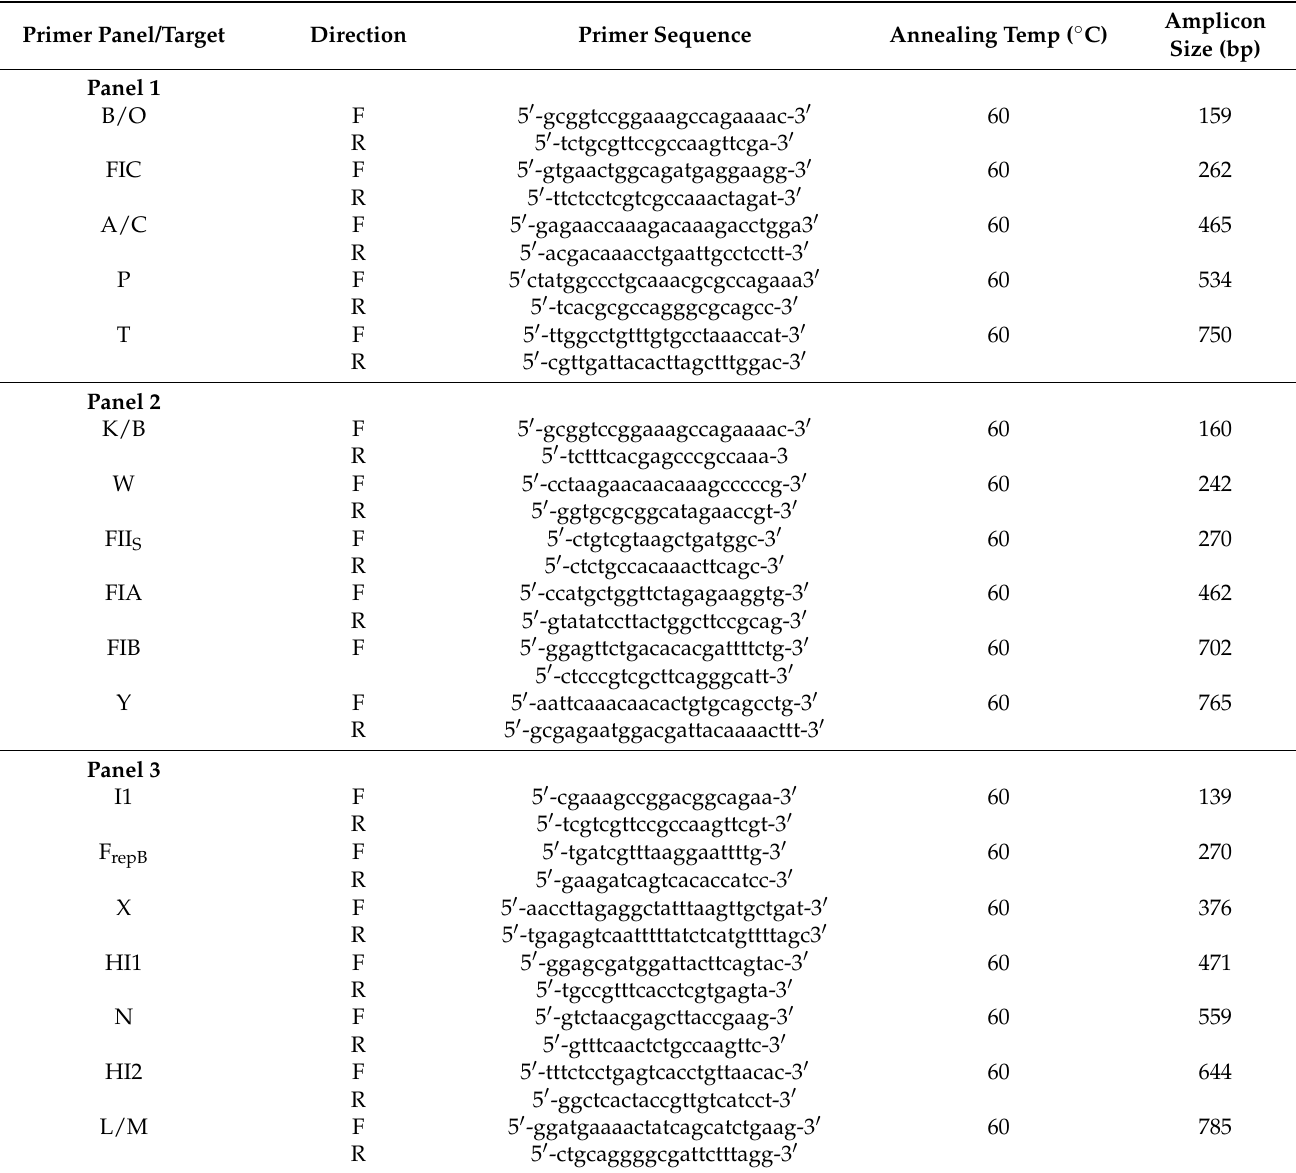
Table 6. Primers used in PCR based replicon typing of donor and transconjugant plasmids. Primer